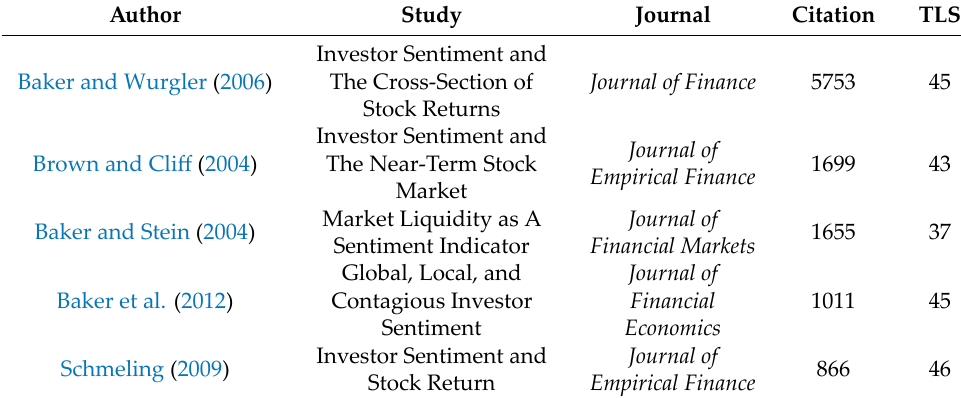
Table 9. Five most influential studies.